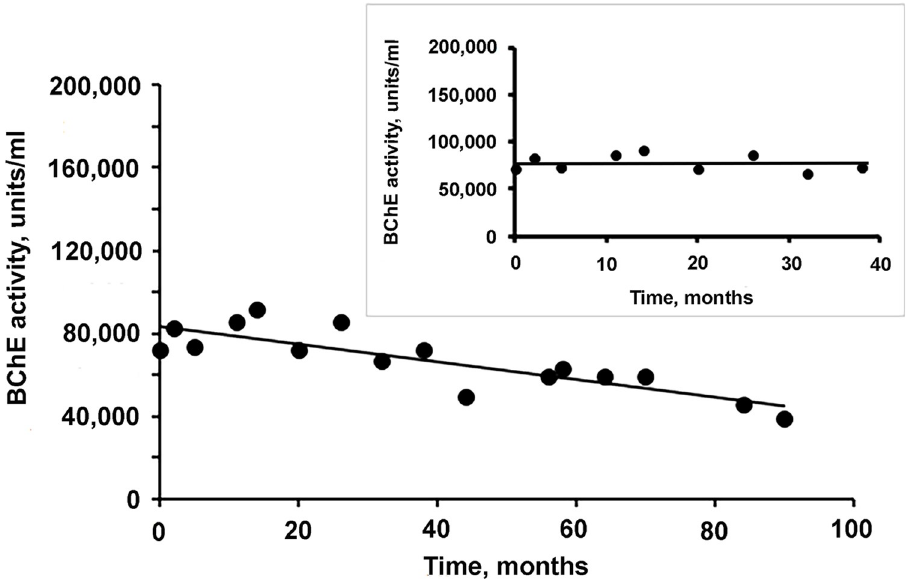
Fig 5. Stability of lyophilized BChE. BChE, purified from new Cohn fraction IV-4, was lyophilized in 52 mM L- histidine pH 6.0 plus 240 mM sucrose, 0.3 mM Tween-20, and stored at 27˚C. 20 separate vials were made. Periodically, a vial was reconstituted in water and the activity of BChE